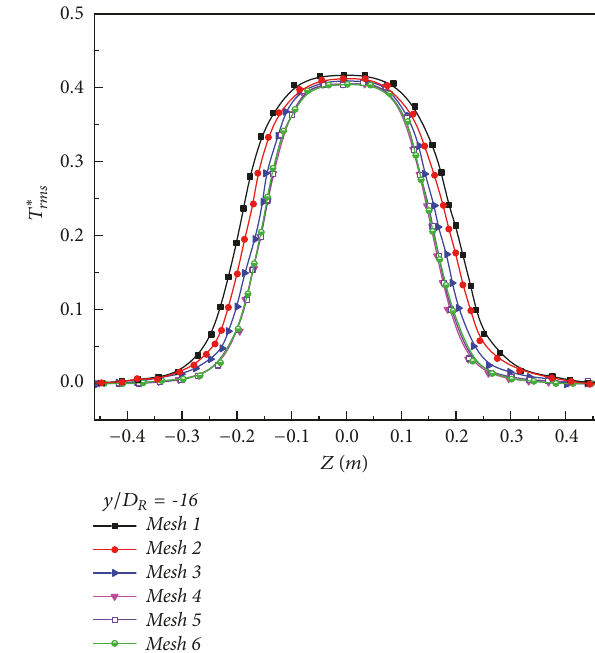
Figure 13: The dimensionless RMS temperature distribution of mesh sensitivity